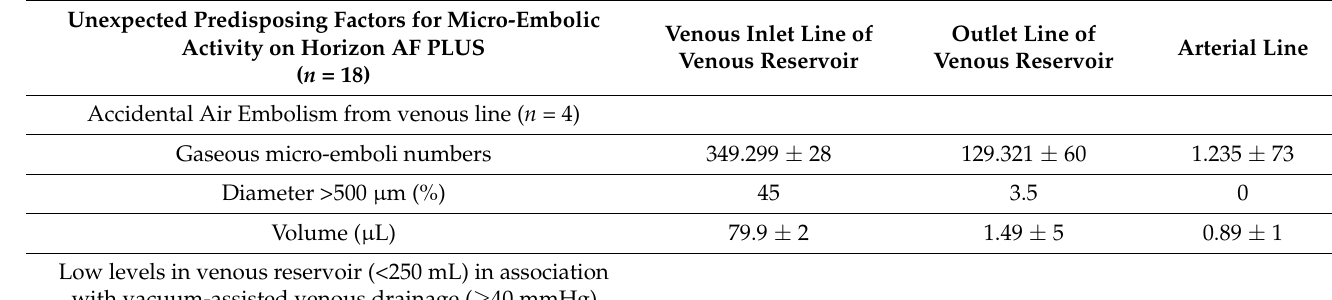
Table 4. Quantification of micro-embolic activity in the circuit for unexpected predisposing factors for micro-embolic activity on Horizon AF